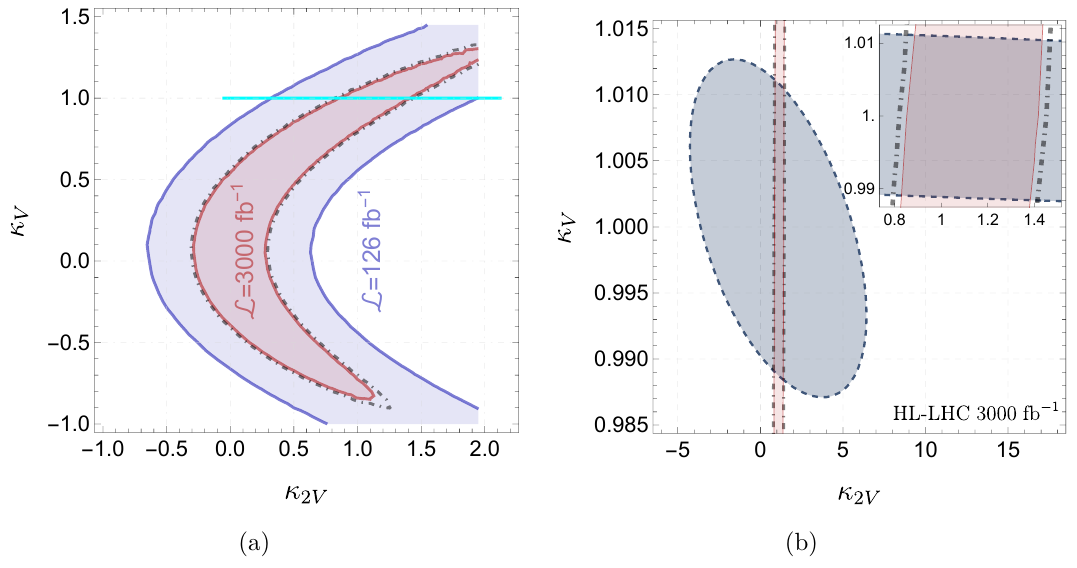
Figure 7 . Exclusion limits on κ 2 V and κ V parameter space obtained from the GNN output trained for the κ 2 V enriched sample ( κ 2 V , κ V = 2 , 1 ) are shown in figure 7(a). The cyan line represents the limits obtained from the ATLAS analysis for the fixed value of κ V = 1 [37]. The dot-dashed contour shows the effect of increasing the background by 25% . In figure 7(b), HL-LHC projected constraints are overlaid on the 95% C.L. region shown in figure 4(b) for κ 2 V and κ V parameter